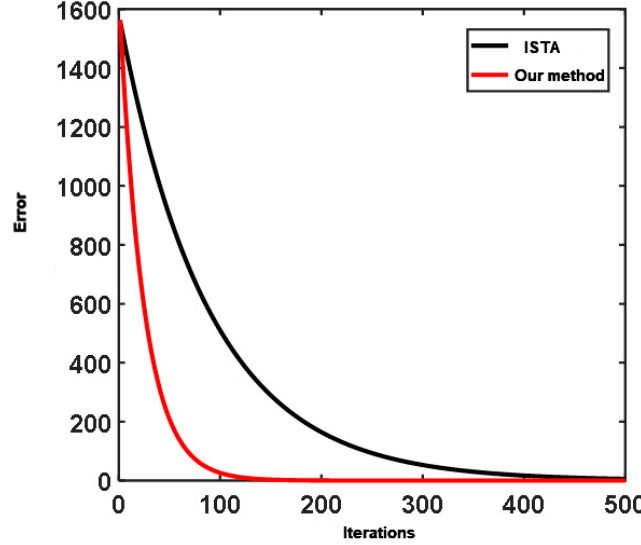
Figure 11. Comparison of the convergence rate curves by the algorithm proposed in this study and conventional ISTA.